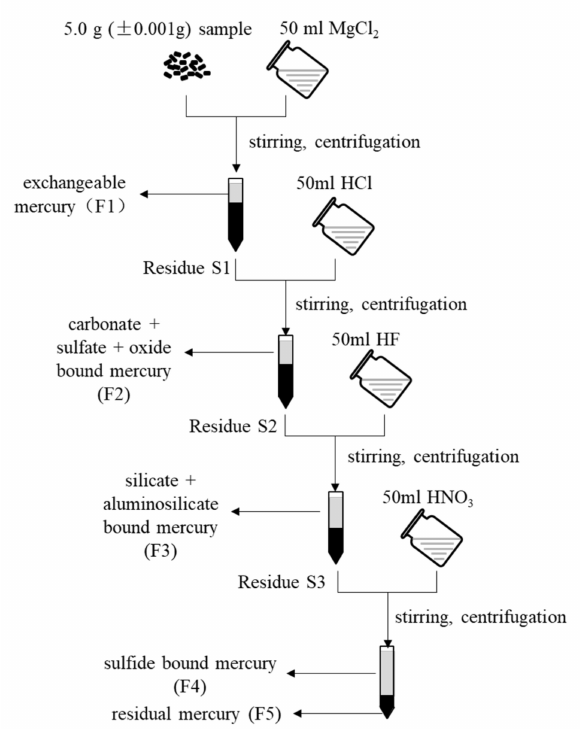
Figure 2. Schematic diagram of sequential-chemical-extraction